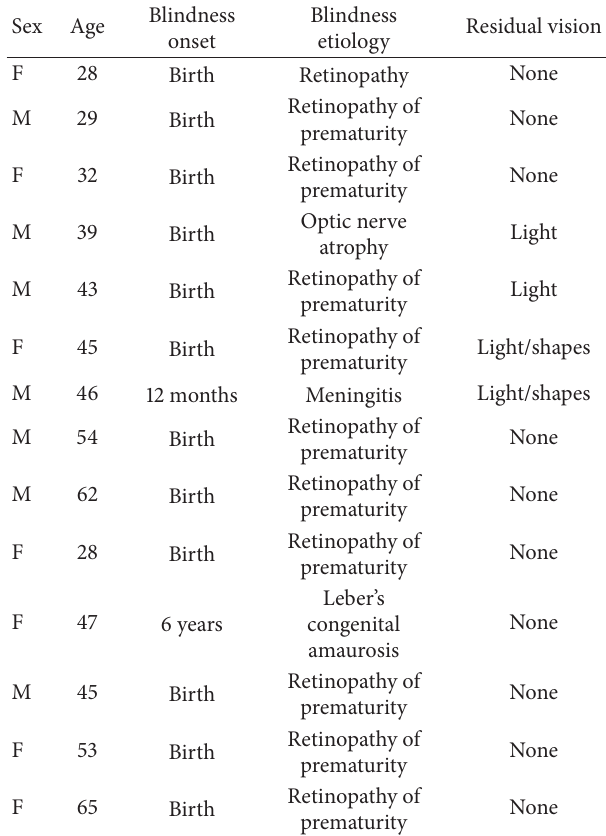
Table 1: Demographic data of blind participants (M = male, F =